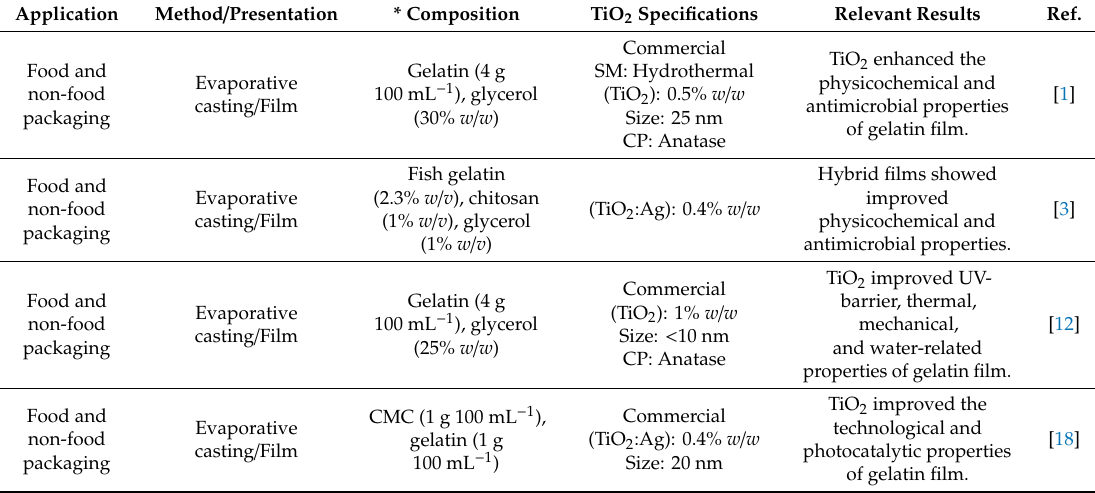
Table 4. E ff ect of TiO 2 incorporation on gelatin matrix Table 4. Effect of TiO 2 incorporation on gelatin matrix properties.